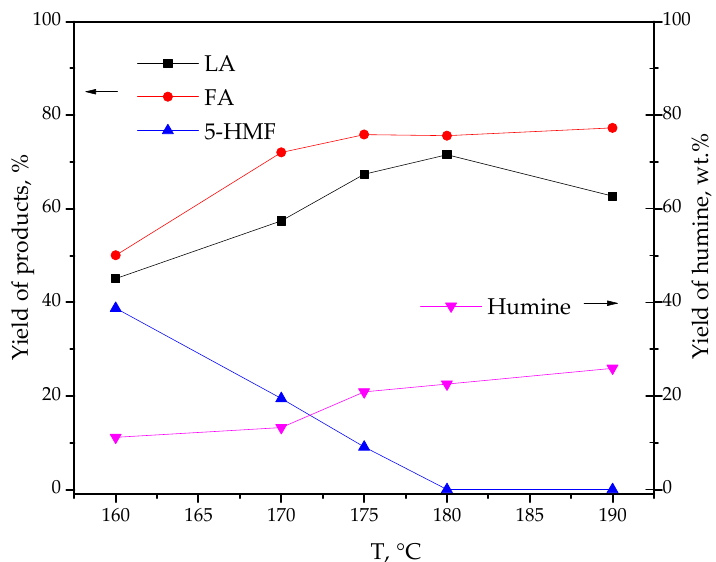
Figure 4. Yield of reaction products versus temperature. Reaction conditions: fructose (2 g, 11.1 mmol, 20 wt.%), H 2 O (10 mL), ZrO 2 –SiO 2 –SnO 2 catalyst (0.1 g) for 5 h.